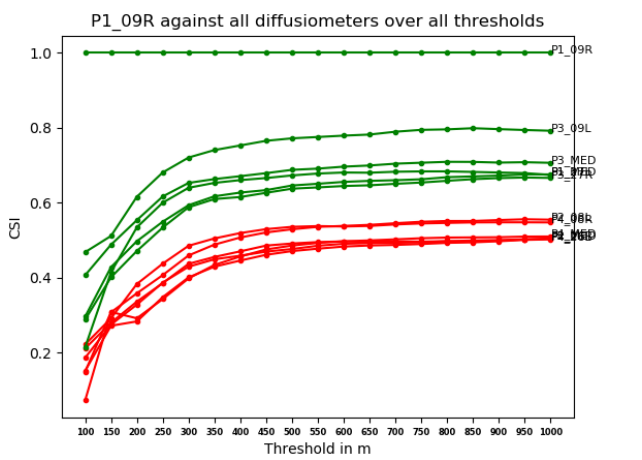
Figure 10. Evolution of CSI as a function of the chosen threshold for a perfect forecast defined by P1-09R. Green and red curves correspond to northern and southern parts of the airport,